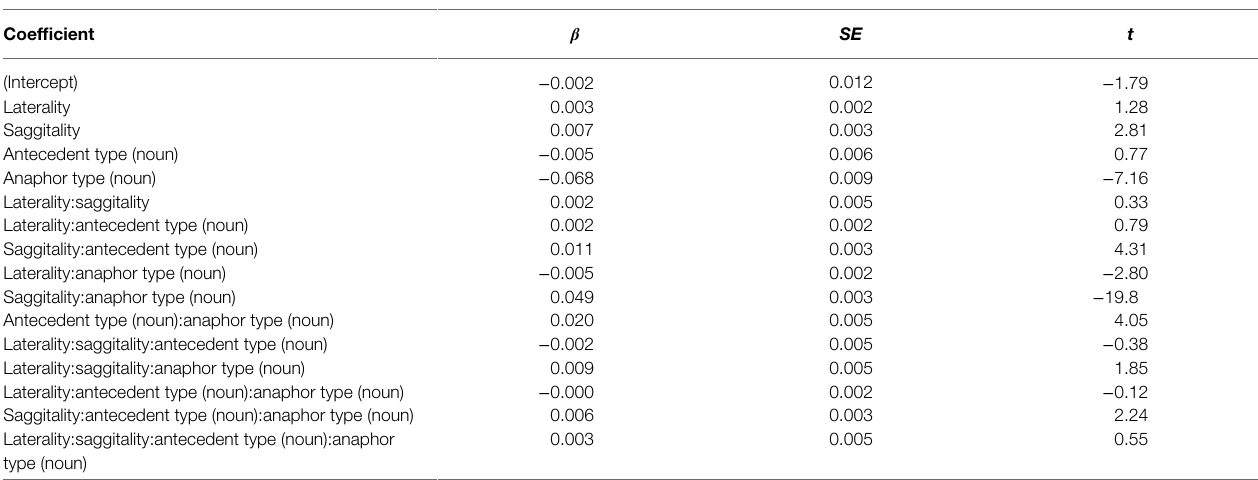
TABLE 3 | Summary of the statistical model of the P300 time